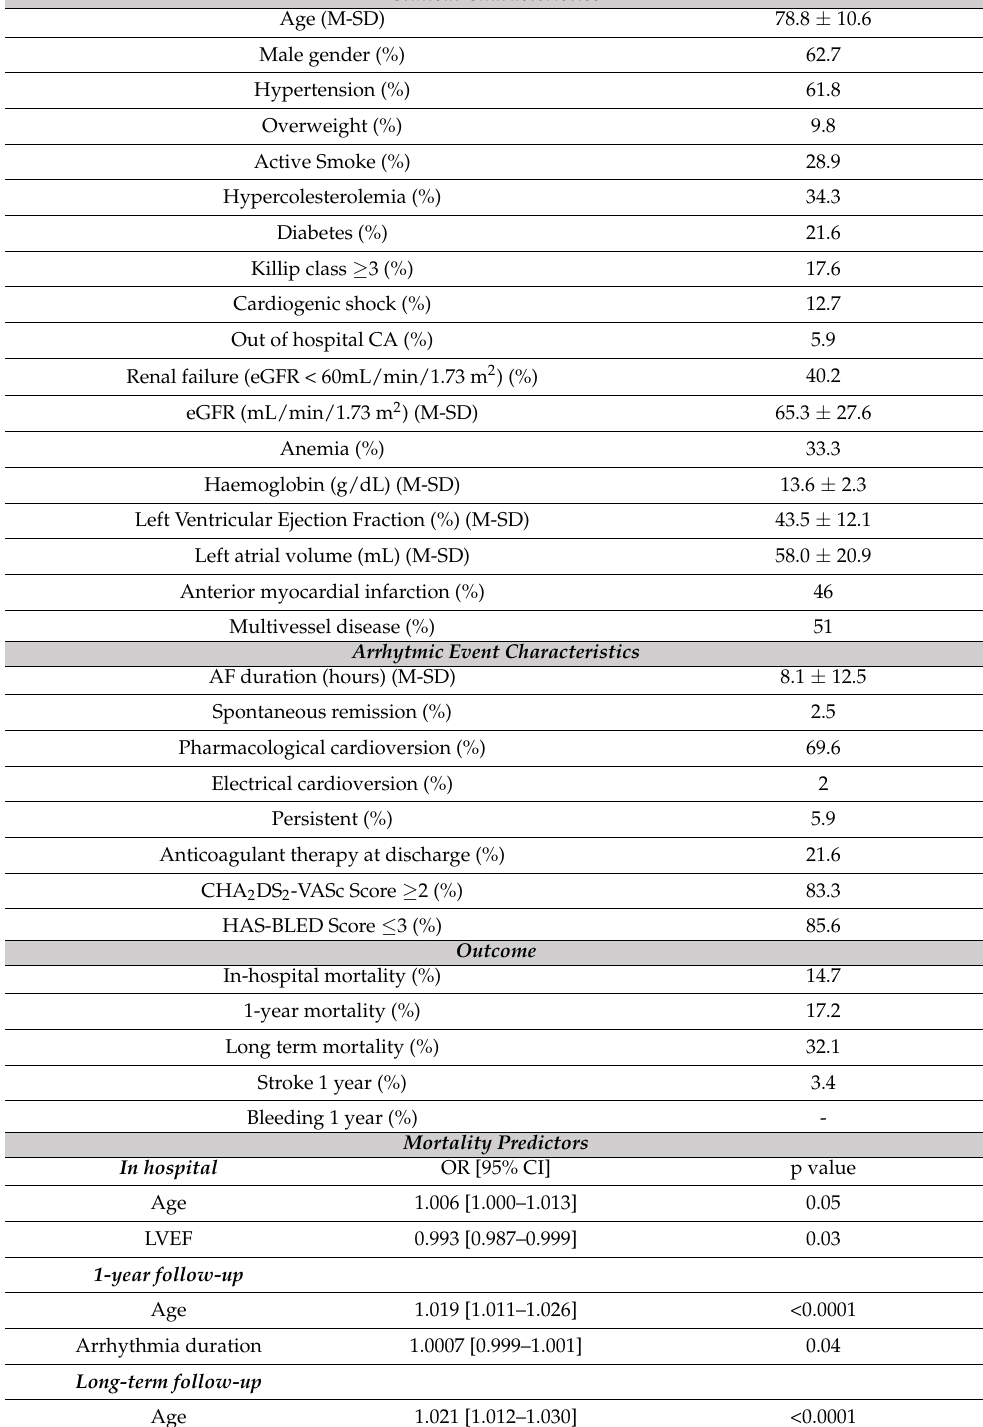
Table 1. Clinical, procedural, arrhythmic events characteristics, and outcomes of the